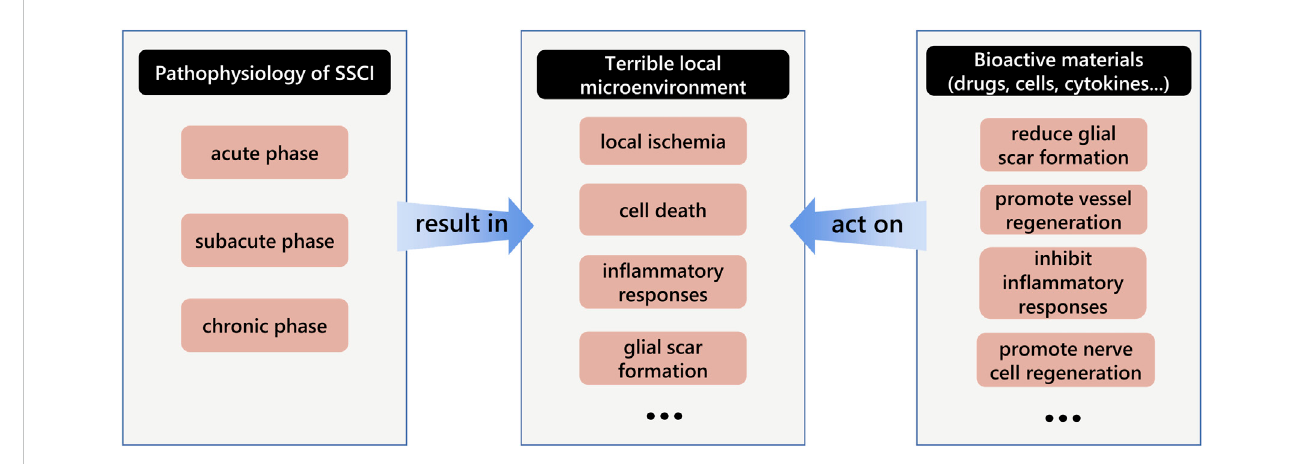
FIGURE 3 Schematic diagram of the interaction among the pathophysiology of secondary spinal cord injury, terrible local microenvironment and bioactive